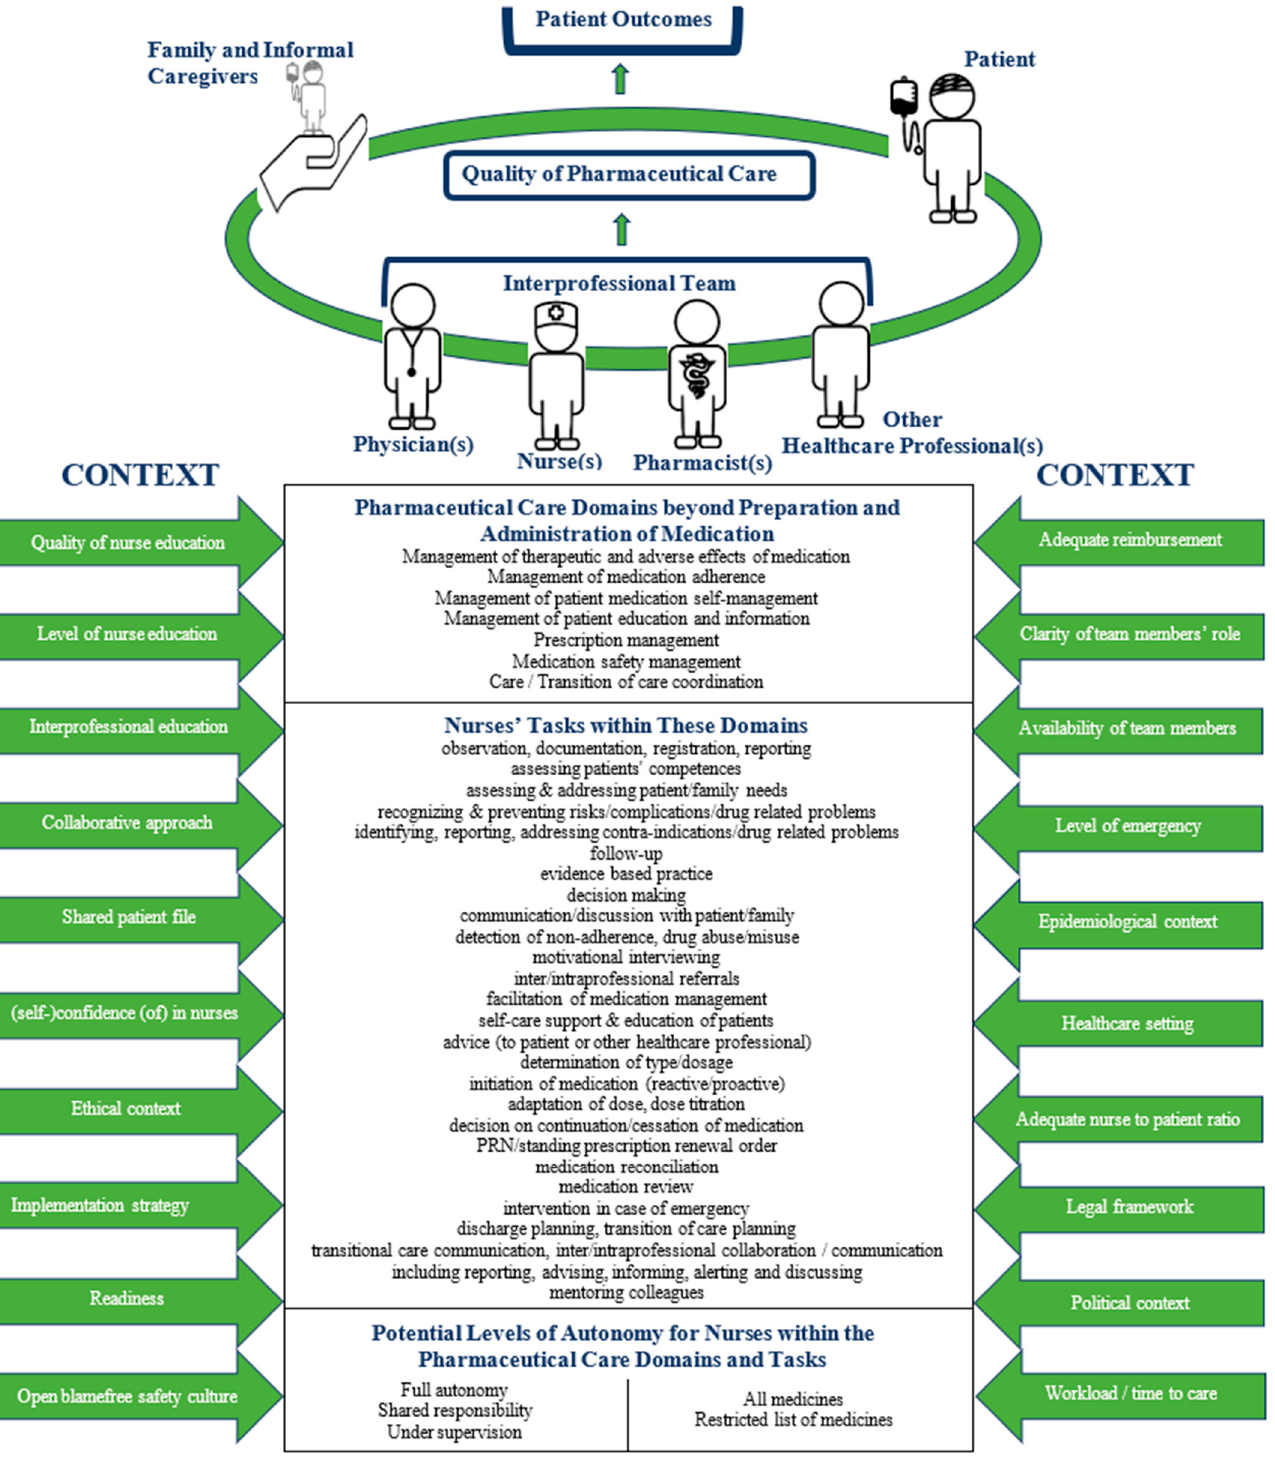
Figure 1 . The NUPHAC ‐ EU framework for Nurses’ role in interprofessional Pharmaceutical Care in Europe. Figure 1. The NUPHAC-EU framework for Nurses’ role in interprofessional Pharmaceutical Care in